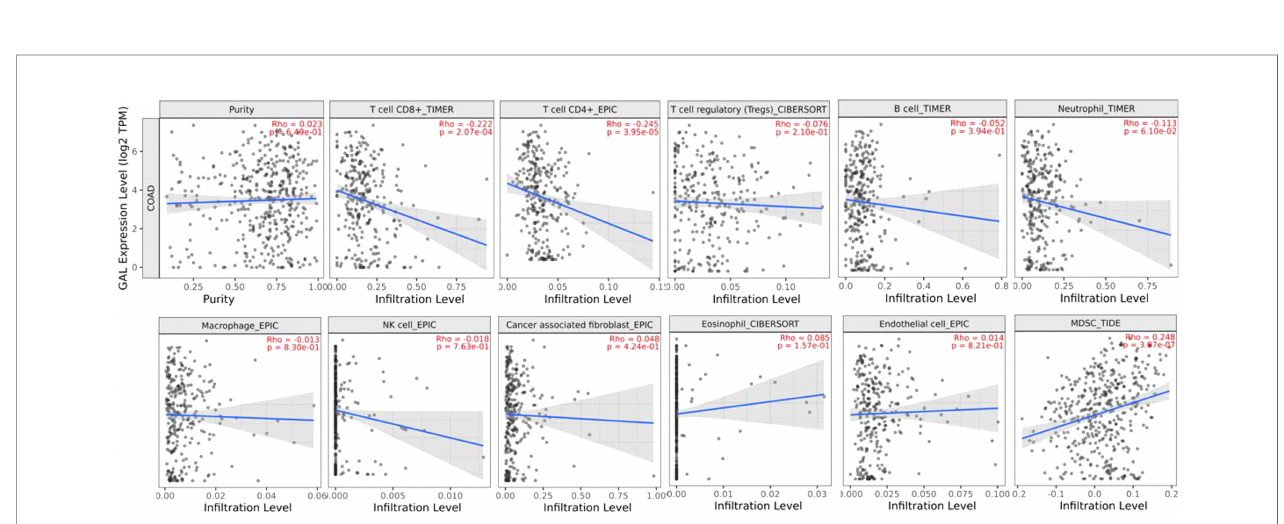
FIGURE 8 | Spearman ’ s rank correlation coef fi cient of immune-in fi ltrating-cell abundance and GAL expression in COAD, using TIMER 2 web